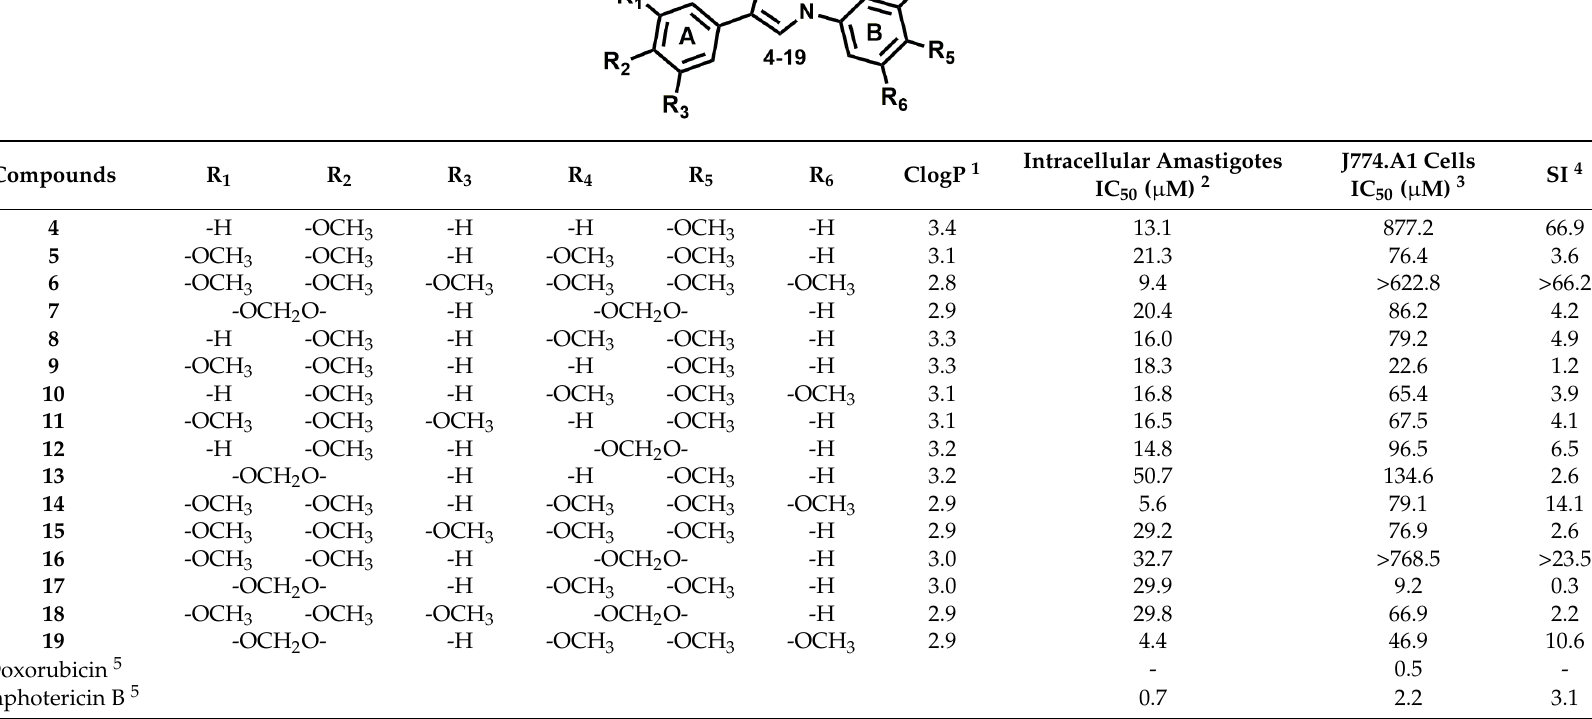
Table 1. Molecular hydrophobicity, in vitro antileishmanial activity and cytotoxicity of 1,4-diaryl-1,2,3-triazole derivatives 4 – 19 of the neolignans 1 – 3 .